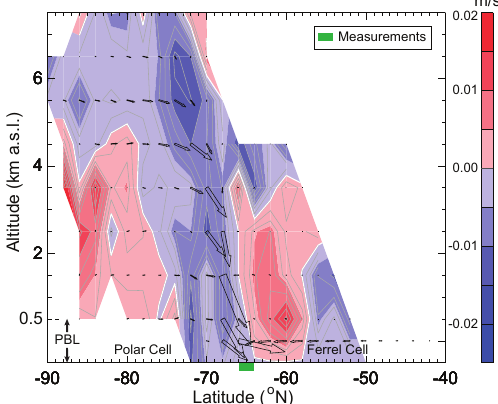
Figure 3. Vertical component of trajectory calculations constructed from a frequency analysis (number of times a trajectory passes through a grid box) of 5-day back trajectories. Trajectories were released at 10m height (a.s.l.) from the marked (green) measure- ment locations every hour of the sea-ice leg of the voyage ( > 1100 trajectories). Free-tropospheric air is observed to reach the sea-ice surface via a well-defined downward flow, just south of the rising polar front. Colour contours describe the mean vertical wind, while overlying vectors show two-dimensional movement weighted by the number of points at each location. Note that the lowest section of the y axis is expanded to show the planetary boundary layer (PBL) in more detail, and the continent is smeared because of longitudinal